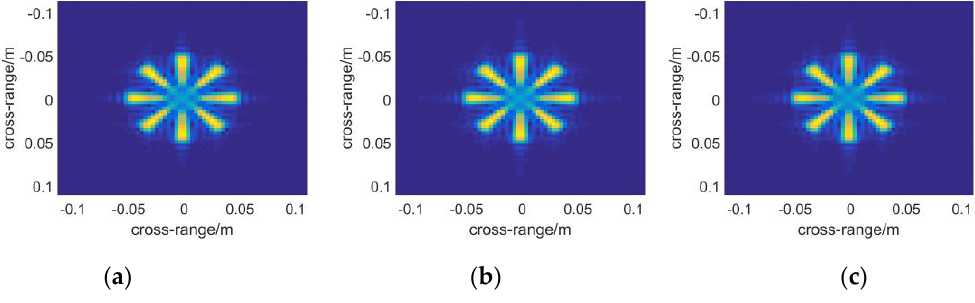
Figure 8. Slice figures reconstructed by the algorithm of: ( a ) BPA; ( b ) RMA; ( c ) PMA.